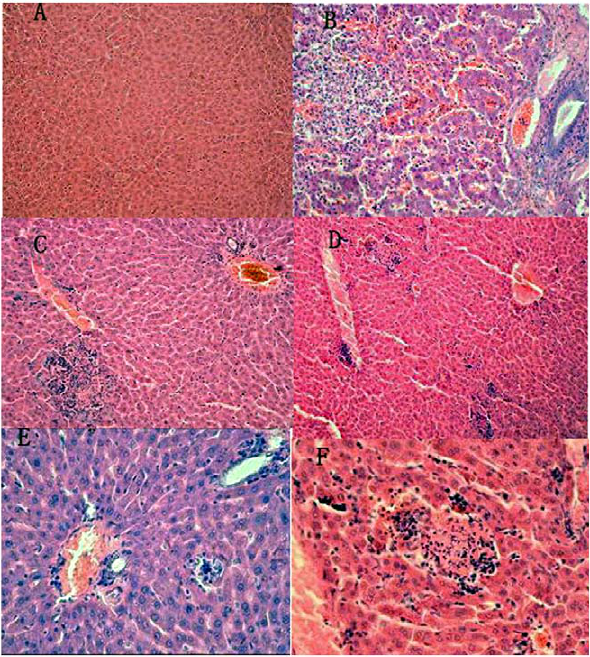
Figure 4. Histopathological analysis of liver sections stained with hematoxylin and eosin (HE). A: liver structure is clear and the liver cells are in order (control group; HE, 20 6 ). B: Sinus congestion, proliferation of fibrous connective tissue in portal area (14 days post- infection; HE 40 6 ). C: Hepatocyte necrosis and lymphocyte infiltration (7 days post-infection; HE, 40 6 ). D: Multiple lymphocyte infiltration (7 days post-infection; HE, 10 6 ). E: Lymphocytic infiltration in Kiernan’s space (28 days post-infection; HE, 20 6 ). F: Lobular necrotic nodules (28 days post-infection; HE, 40 6 ).